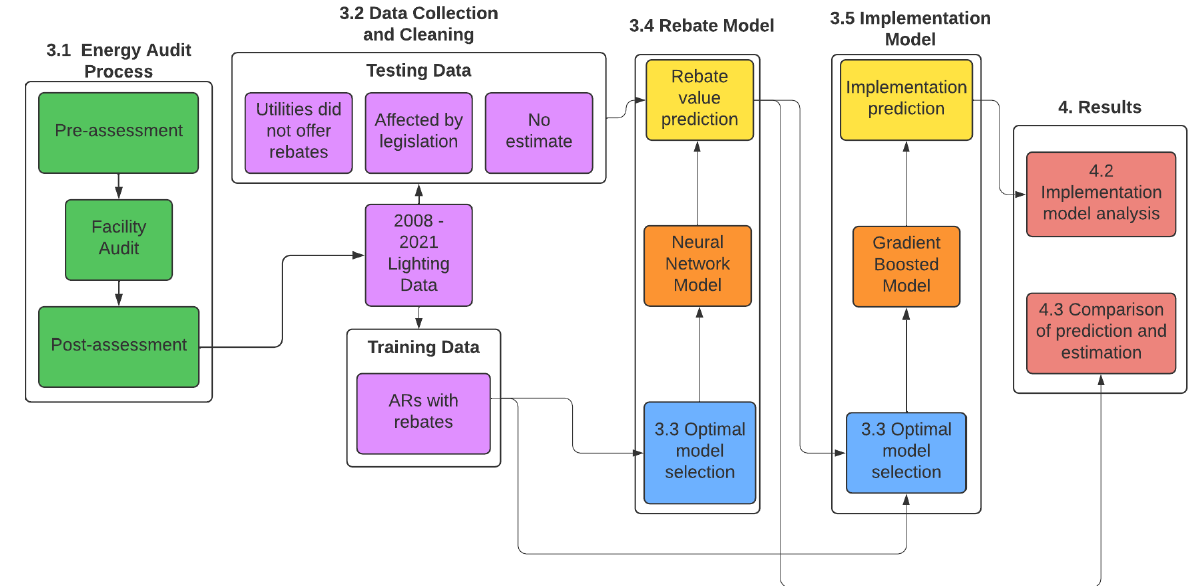
Figure 1. Research framework for using ML to analyze the impact of lighting utility rebates.